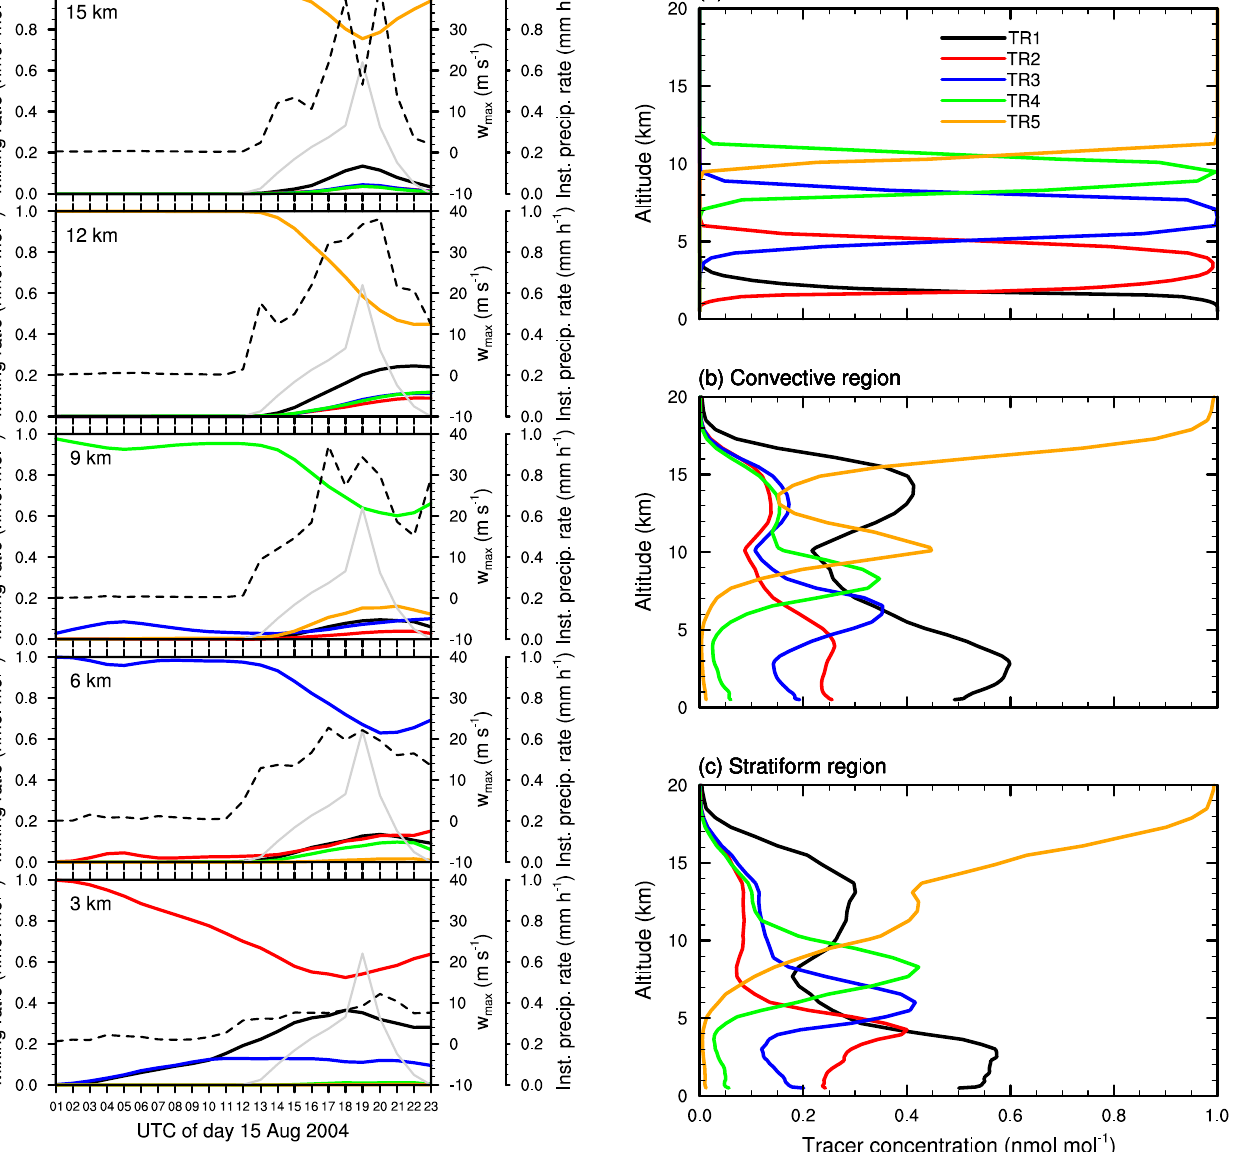
Fig. 8. Time evolution of the tracers mixing ratios (nmolmol − 1 ) on 15 August 2004, TR1 (black), TR2 (red), TR3 (blue), TR4 (green) and TR5 (yellow) for five altitudes (15km, 12km, 9km, 6km and 3km altitude). Black dashed and grey solid lines are max- imum vertical velocity (ms − 1 ) and instantaneous precipitation rate (mmh − 1 ), respectively. The parameters are averaged over the sub- domain (16.6–19.0 ◦ N ; 6.4–9.0 ◦ E).